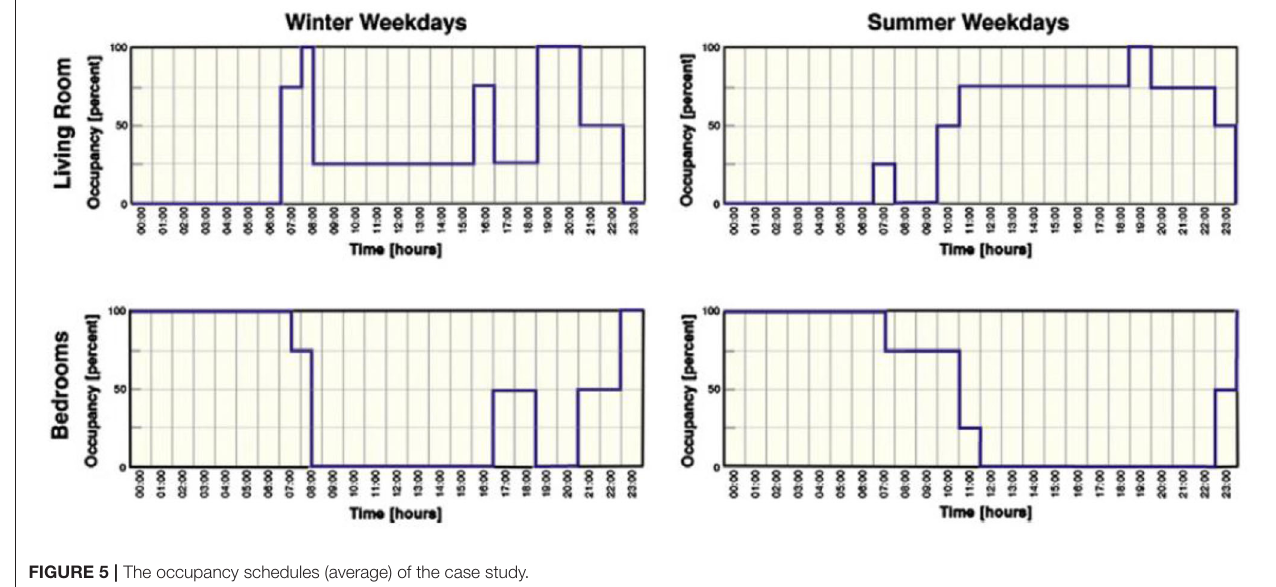
FIGURE 5 | The occupancy schedules (average) of the case study.